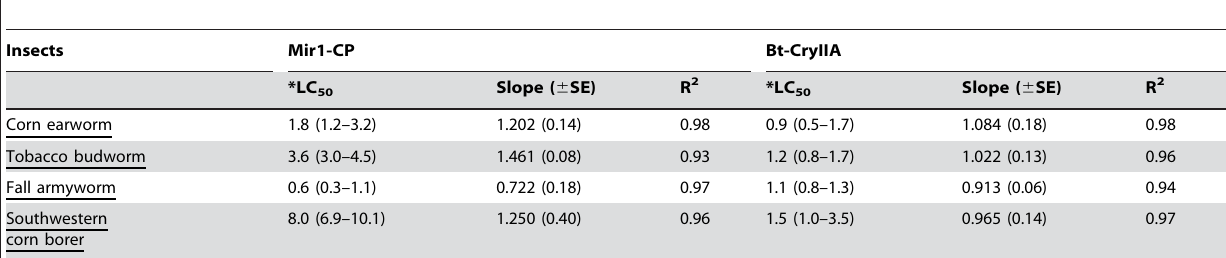
Table 1. Probit analysis of LC 50 values for several Lepidopteran species fed Mir1-CP and Bt-CryIIA. LC 50 values are in ppm and numbers in parenthesis represent the 95% confidence